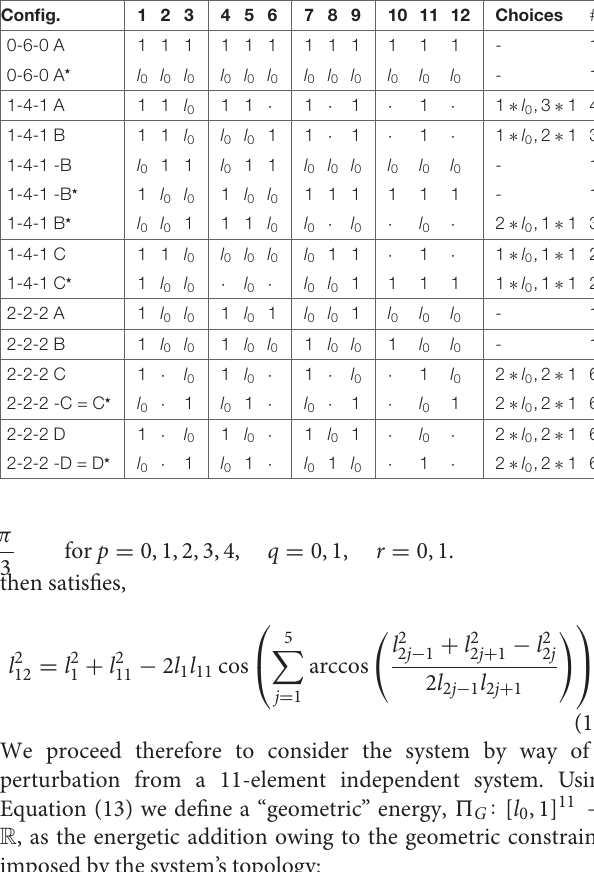
TABLE 2 | The 44 hexagons for generic l 0 . Here ⋆ denotes a hexagon with lengths l 0 and 1